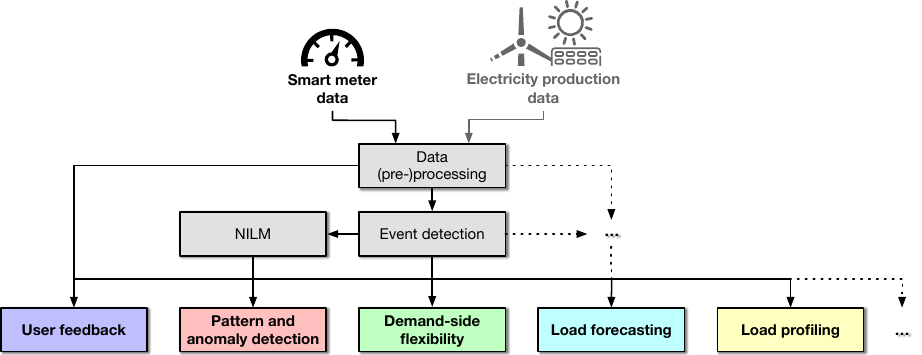
Figure 2. Overview of consumer-centric services enabled by smart meter data and their proper data (pre-)processing. Dashed lines indicate the possible existence of other potential (pre-)processing steps or use cases beyond those covered in this